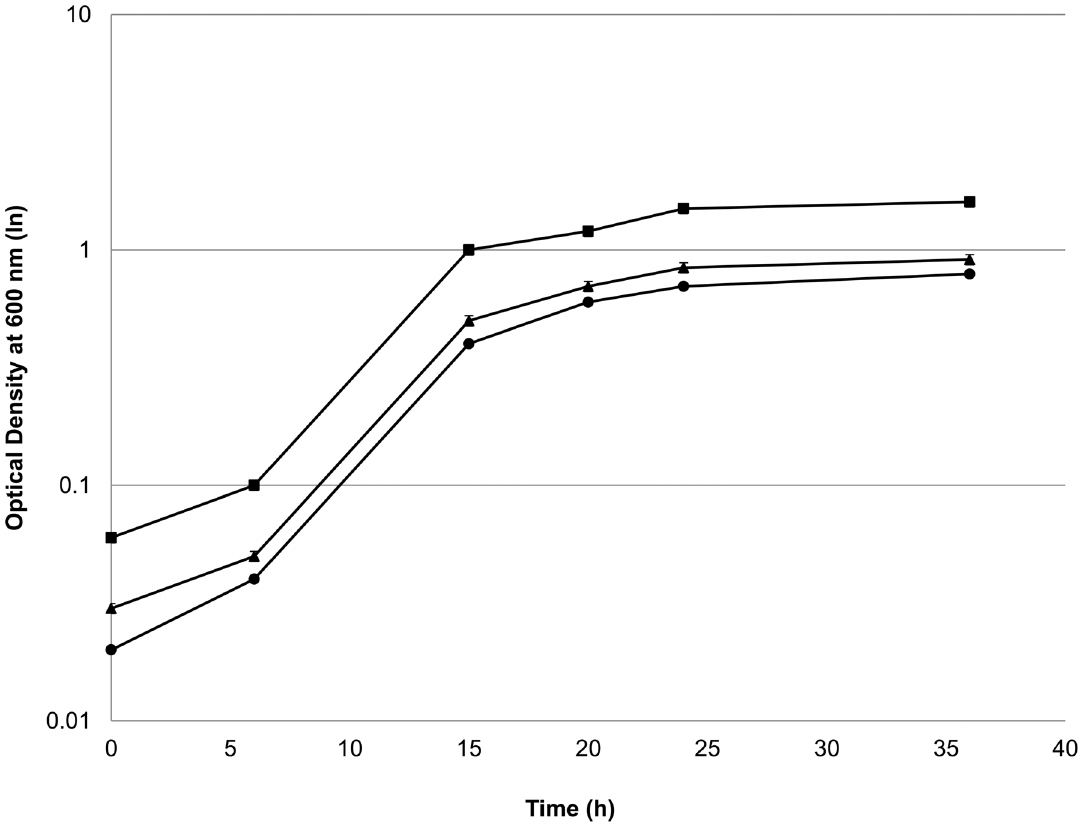
Figure 3. Growth profile of C.thermocellum mutants on rich medium. Symbols: closed square, C. thermocellum wild type; closed circle, C. thermocellum adhE* (EA); closed triangle, C. thermocellum adhE* (EA) D ldh .